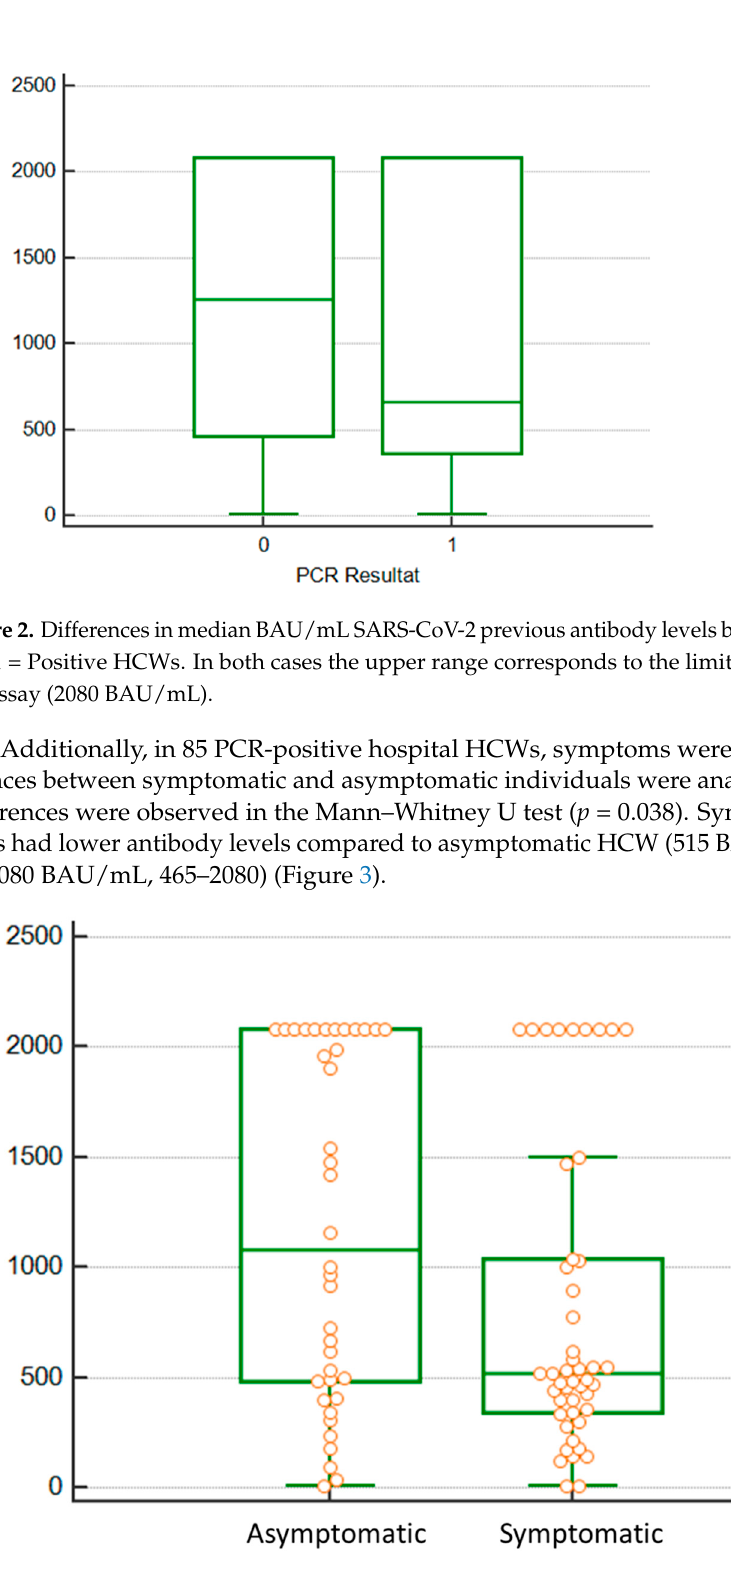
Figure 3. Differences in median BAU/mL SARS-CoV-2 previous antibody levels between infected HCWs that were recorded as not symptomatic ( n = 40) and symptomatic ( n = 45). All single dots are overlaid on the box and whisker plot, as the number of outliers is remarkable. Regarding the type of symptoms, no severe COVID-19 patients were identified. Symptom classification is depicted in Table 2.